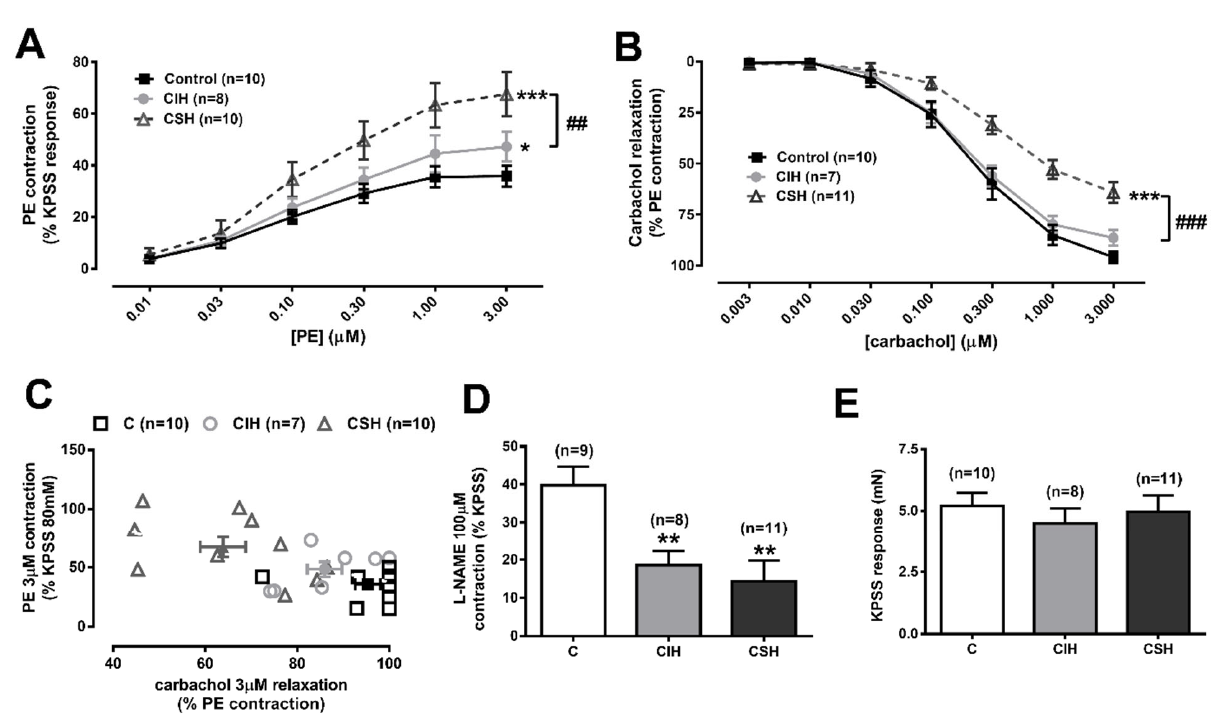
Figure 2. Intrapulmonary artery (IPA) wire myography. ( A ) Phenylephrine (PE) dose response (0.01–3 µ M) as % of the KPSS response, in C, CIH, and CSH arteries; Data are expressed as mean ± SEM; * p < 0.05, *** p < 0.001 vs. control curve (two-way ANOVA with Sidak multi comparison test); ## p < 0.01 CIH vs. CSH. ( B ) Dose response relaxation to carbachol (0.003–3 µ M) as % of a stable submaximal PE contraction in C, CIH, and CSH arteries; Data are expressed as mean ± SEM; *** p < 0.001 vs. control curve (two-way ANOVA with Sidak multi comparison test); ### p < 0.001 CIH vs. CSH. ( C ) Interpolation of the maximal contraction to PE (Y-axis) with the maximal relaxation to carbachol (X-axis) for each individual artery, with the average values for each animal group. ( D ) 100 µ M L-NAME responses, expressed as % of the KPSS response in C, CIH, and CSH; Data are expressed as mean ± SEM; ** p < 0.01 vs. C rats (one-way ANOVA with Tukey multi comparison test). ( E ) Response of IPA to 3 min of PSS with 80 mM K + (KPSS), expressed in mN, and in C, CIH, and CSH arteries. Data are expressed as mean ±